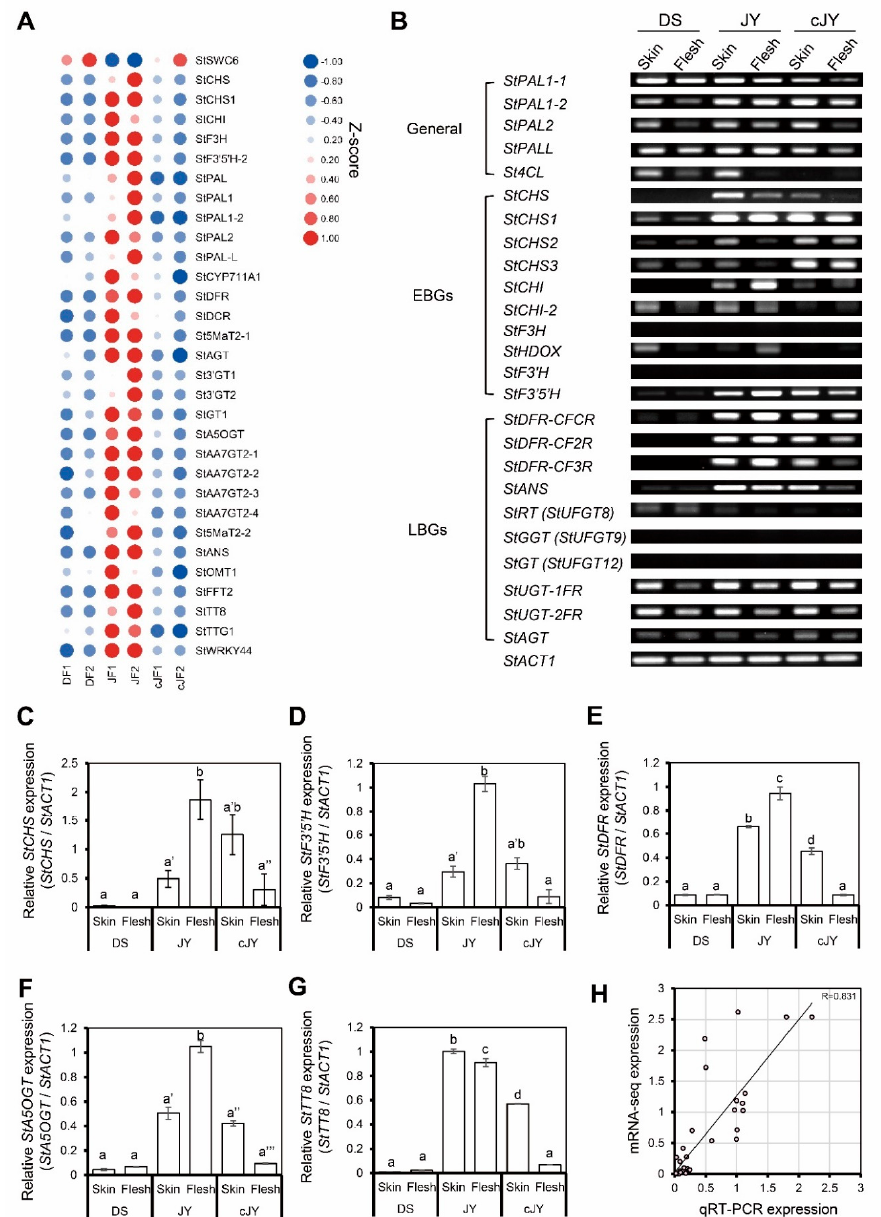
Figure 5. Anthocyanin-related genes were positively correlated with JF. ( A ) Heatmap of anthocyanin- related genes from mRNA-seq. Z-scores for each gene were used. Numbers in sample names indicate biological replicate number. ( B ) RT-PCR of anthocyanin biosynthetic genes. General in- dicates general pathway genes in flavonoid biosynthetic pathway, EBG indicates early biosyn- thetic genes, and LBG indicates late biosynthetic genes. StACT1 was used as an internal control. ( C – G ) qRT-PCR of anthocyanin-related genes. Relative expression levels of each gene were deter- mined by 2 − ∆∆ CT method. Letters represent significant differences based on one-way ANOVA and Tukey’s test ( p < 0.05). Two biological replicates were analyzed. ( C ) Relative expression level of StCHS . ( D ) Relative expression level of StF3 (cid:48) 5 (cid:48) H . ( E ) Relative expression level of StDFR . ( F ) Relative expression level of StA5OGT . ( G ) Relative expression level of StTT8 . ( H ) Linear regression analysis between qRT-PCR expression and mRNA-seq data. Relative expression levels of each gene were determined by 2 − ∆∆ CT method, as indicated in the x axis, while the TMM-normalized TPM of target genes divided by that of StACT1 is indicated in the y